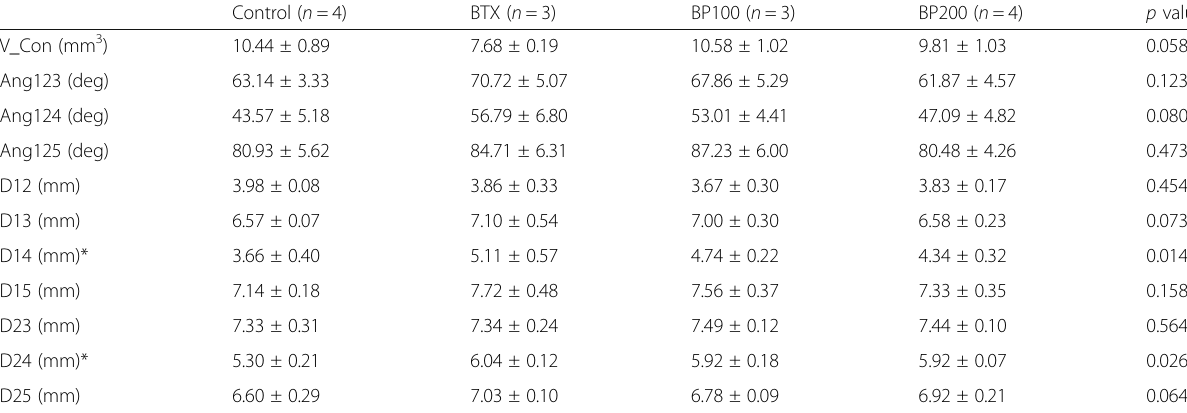
Table 3 Volumetric, angular, and linear analysis of the left side of the mandible Control ( n =